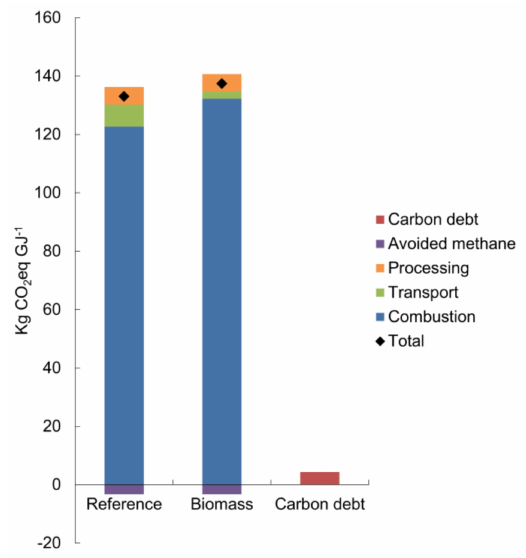
Figure 4. Direct GHG emissions in CO 2 equivalents per GJ produced for the biomass scenario and reference scenario respectively. The difference between the two scenarios is termed the carbon debt, which is paid back through avoided GHG emissions from decaying forest